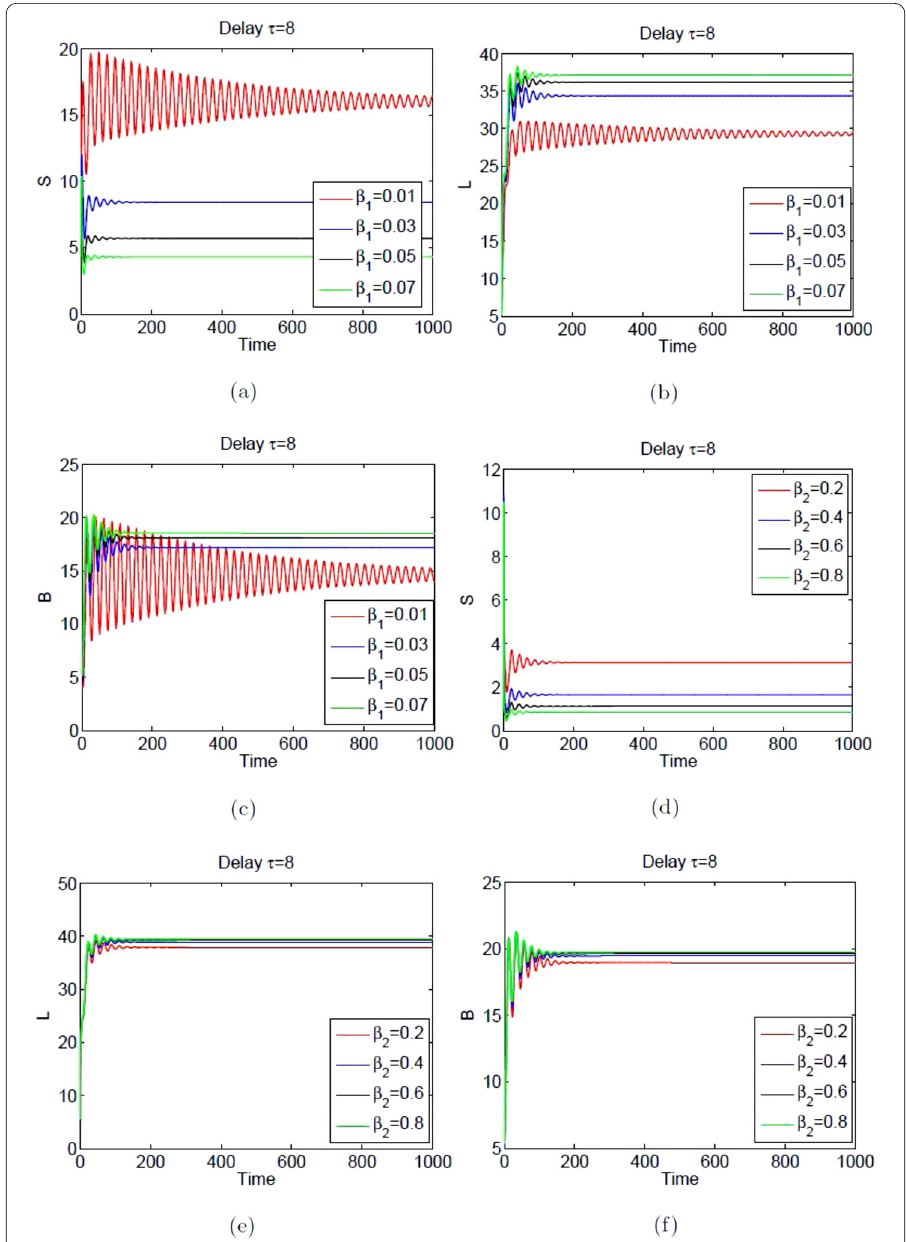
Figure 3 Effect of infected rates ( β 1 , β 2 ) on system dynamics ( a ) uninfected/susceptible node, ( b ) latent node, and ( c ) breaking-out node with τ = 8. The values of other parameters are as in (31)